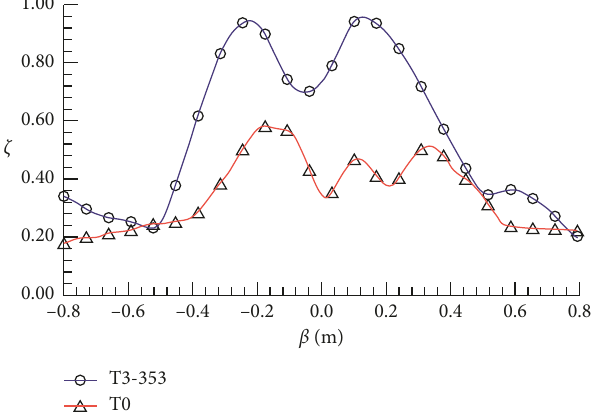
Figure 20: Variation of dissipation rates on L